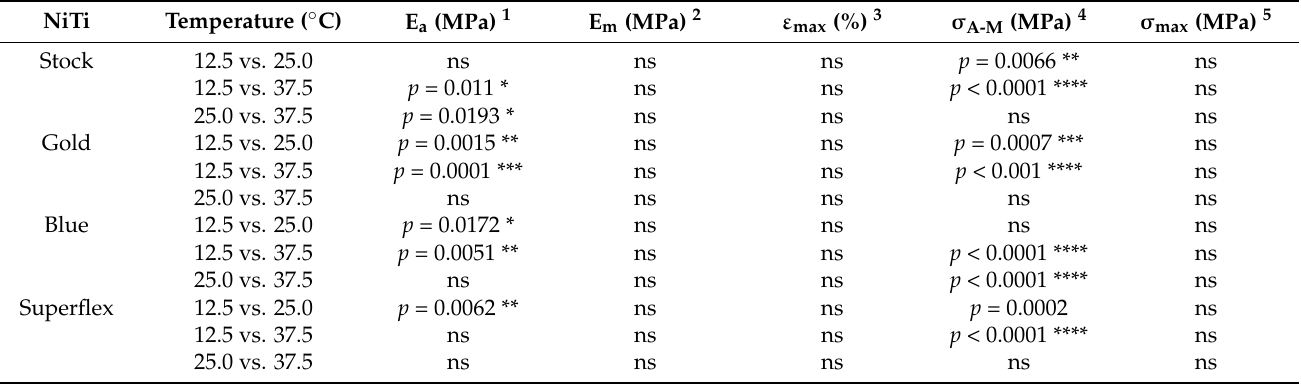
Table 3. Multiple statistical comparisons for the influence of temperature. Data show comparisons of E a , E m , ε max , σ A-M , and σ max for samples within their own alloy groups, at different tempera- tures. Significant outcomes are summarised as follows: * = p < 0.05; ** = p < 0.01; *** = p < 0.001; **** = p < 0.0001.